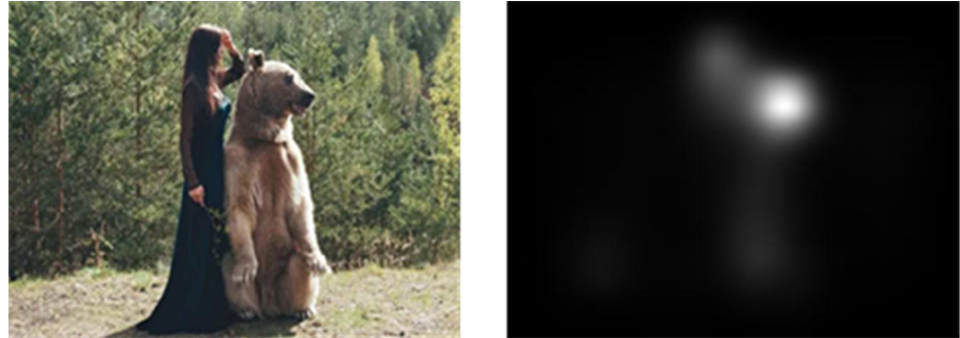
Figure 1. In the picture, the animal attracts considerably more attention than the